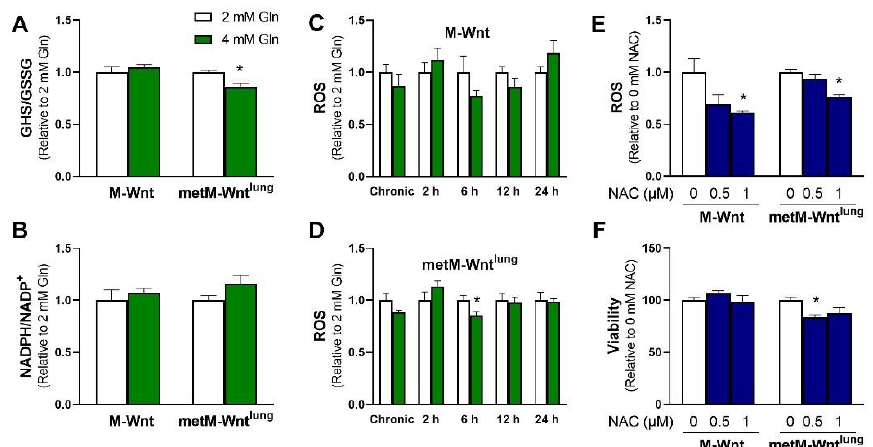
Figure 2. Effect of glutamine concentration on oxidative stress markers. ( A ) GSH/GSSG and ( B ) NADPH/NADP + ratios were measured in M-Wnt and metM-Wnt lung cells; ( C , D ) ROS levels were assessed in M-Wnt and metM-Wnt lung cells chronically grown in 2 mM or 4 mM glutamine, and in cells grown in 4 mM glutamine for indicated times; ( E , F ) the effects of N-acetylcysteine (NAC) on ROS and viability were assessed in cells grown in 4 mM glutamine. Results are expressed as means + SEM. Asterisk (*) indicates p < 0.05 relative to 2 mM glutamine (in A , D ) or relative to 0 mM NAC ( E , F ).